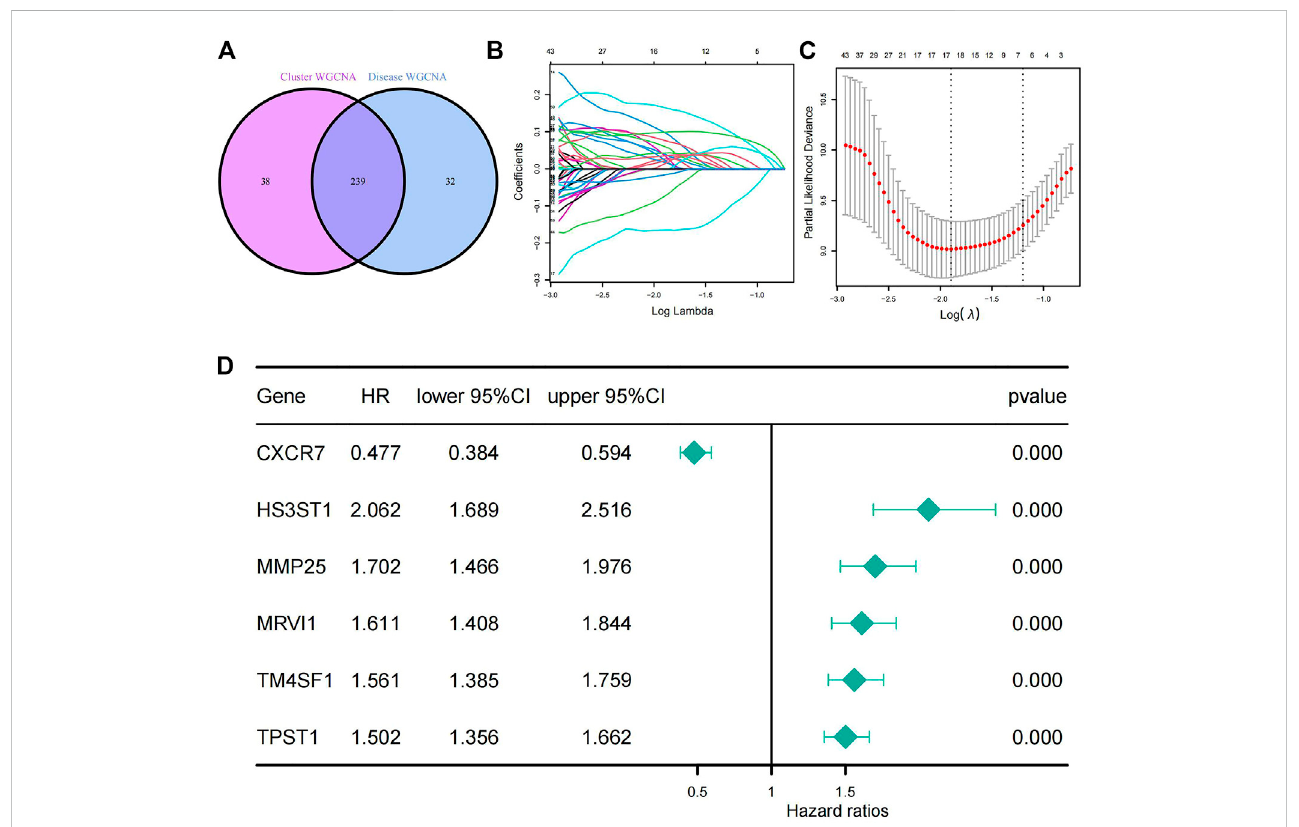
FIGURE 6 Generation of a prognostic model for patients with IPF. (A) The Venn diagram of the 239 EMT-related genes which got from the intersection of WGCNA results. (B) LASSO coef fi cient pro fi les of the 239 genes. (C) The largest λ value ( λ = 6) in the mean square error within the standard error. (D) Univariate Cox analysis of the six selected genes. All p -values from the univariate Cox analysis of the six genes are less than .000. IPF, idiopathic pulmonary fi brosis; LASSO, least absolute shrinkage and selection